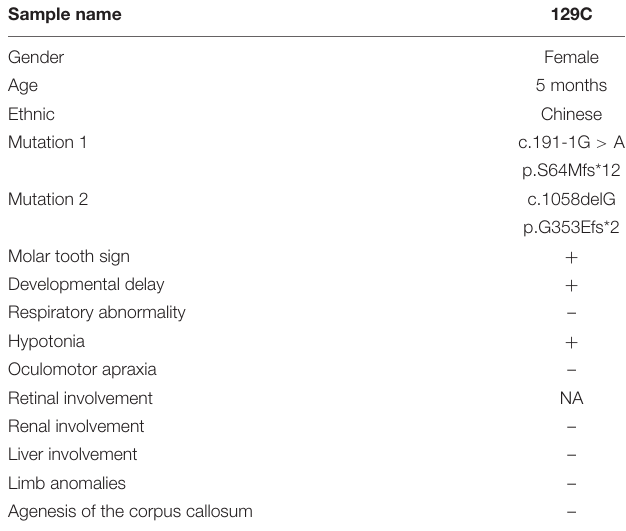
TABLE 1 | Clinical features and